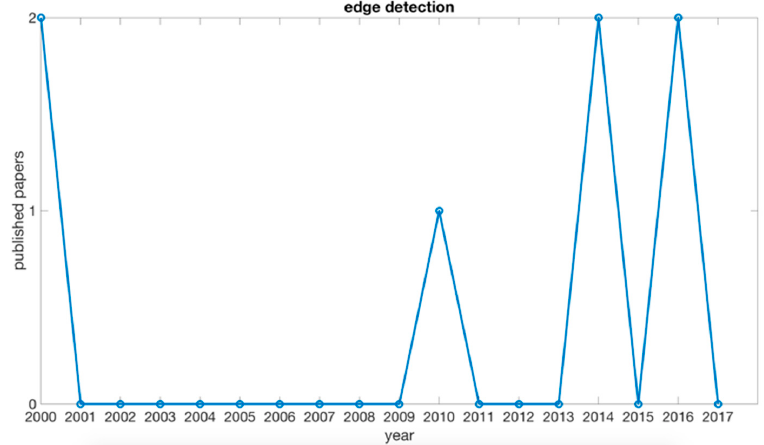
Figure 6. Number of published papers by year for edge detection research papers. Table 4. Authors with recurring publication in the area of edge detection. Edge Detection Number of Recurring Publications Melin P.